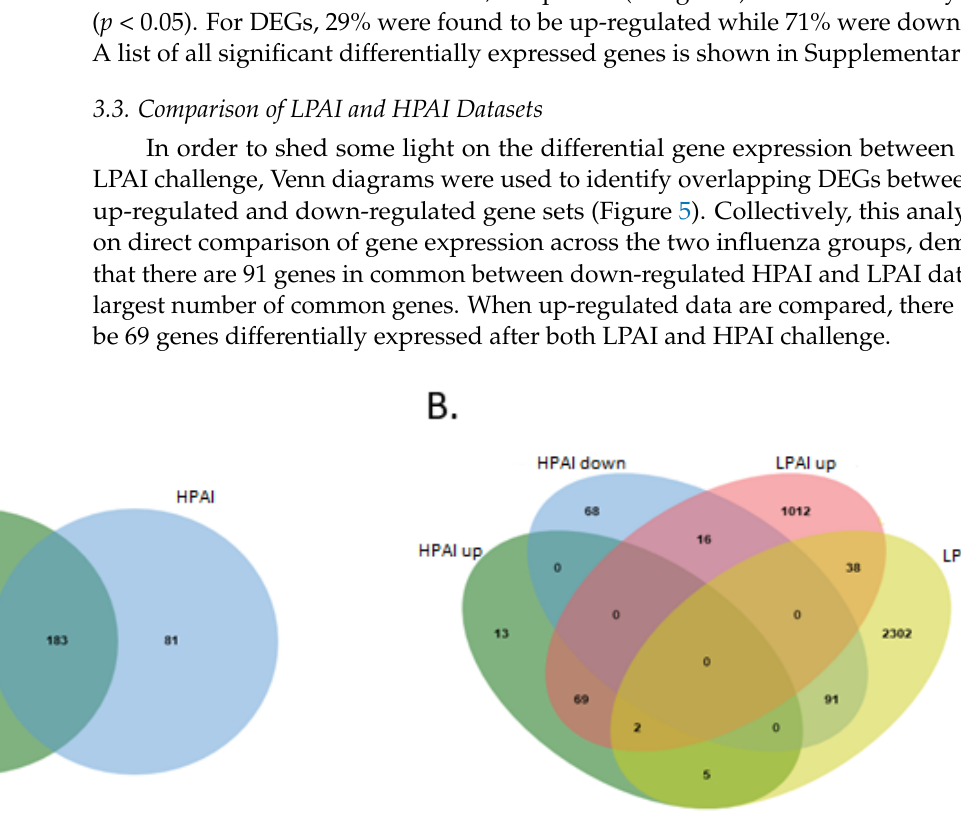
Figure 5. Intersected analysis was used for the identification of common DEGs from all ten datasets. ( A ) Total differentially expressed genes between HPAI and LPAI from across all possible group comparisons. ( B ) Venn diagram showing up- and down-regulated genes in HPAI and LPAI experiments. Different coloured regions represent different datasets, and the intersecting area denotes the common DEGs. (DEGs, differentially expressed genes; HPAI, highly pathogenic avian influenza; LPAI, lowly pathogenic avian influenza).